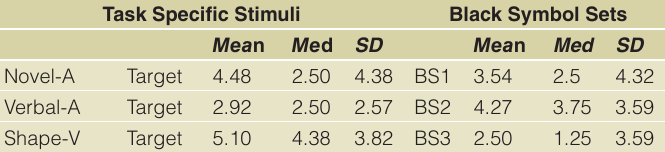
Table 1. Mean and median (+ SD) percent error rate for target and non- target (other) trials on the six discrimination tasks: novel